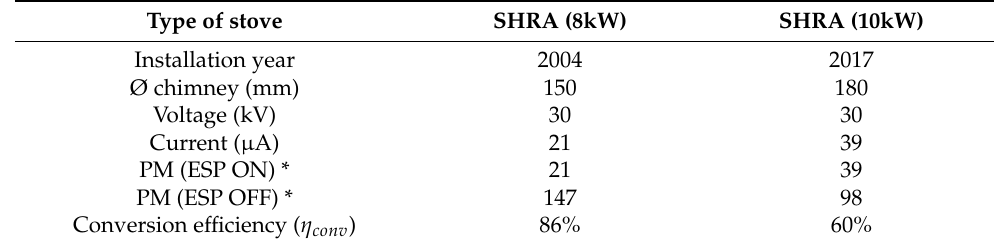
Table 5. Results of field measurements on two SHRA during ON and OFF periods of ESPs installed on the roof of the buildings within the chimney system [85].